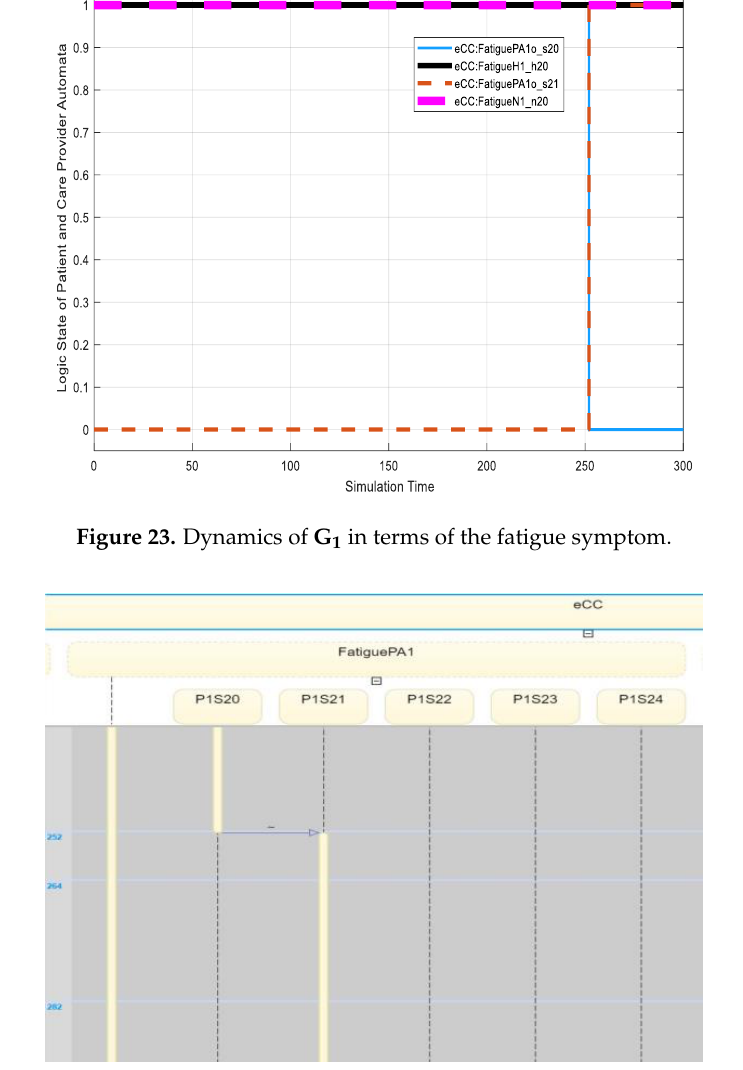
Figure 24. Internal transition of 𝑷𝑨 𝟏𝟎 in holon 𝒔 𝟐 from 𝒔 𝟐𝟎 to 𝒔 𝟐𝟏 (P1S20 to P1S21); this event was not shared with the nursing station.